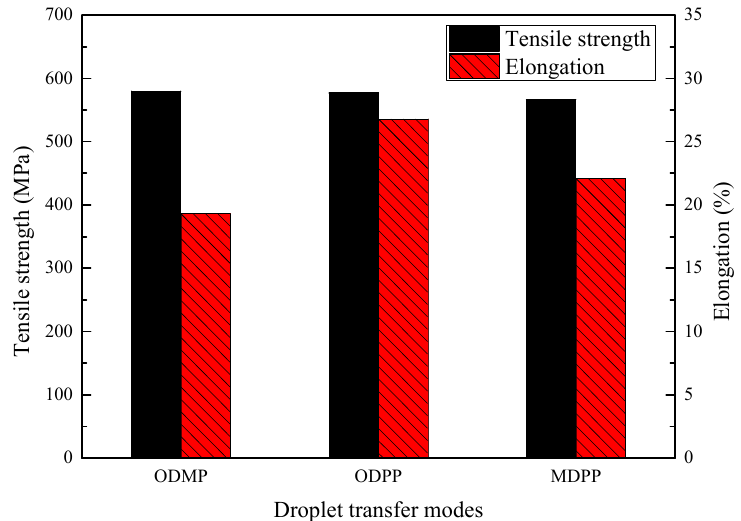
Figure 7. The tensile strengths and elongations of the welded joints with three typical modes of droplet transfer.